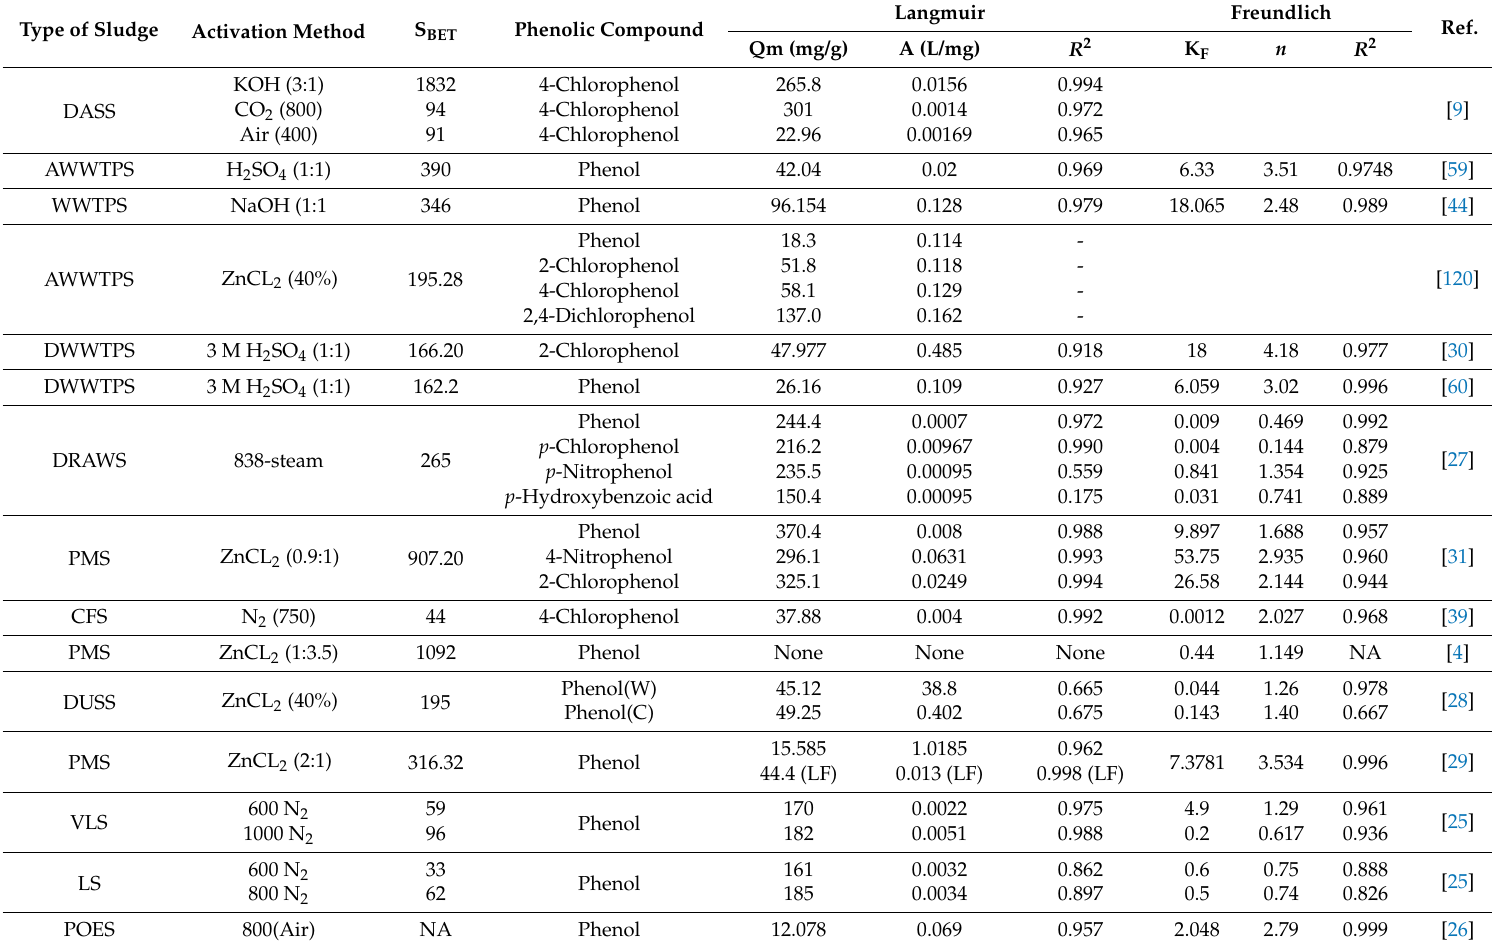
Table 6. Comparison of Langmuir and Freundlich isotherm parameters for adsorption of phenolic compounds by various SBACs produced by different methods. Type of